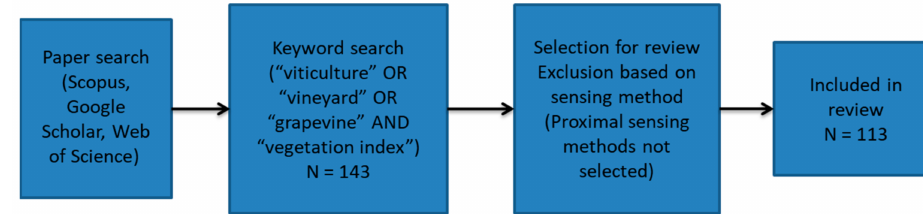
Figure 1. Phases of review method.